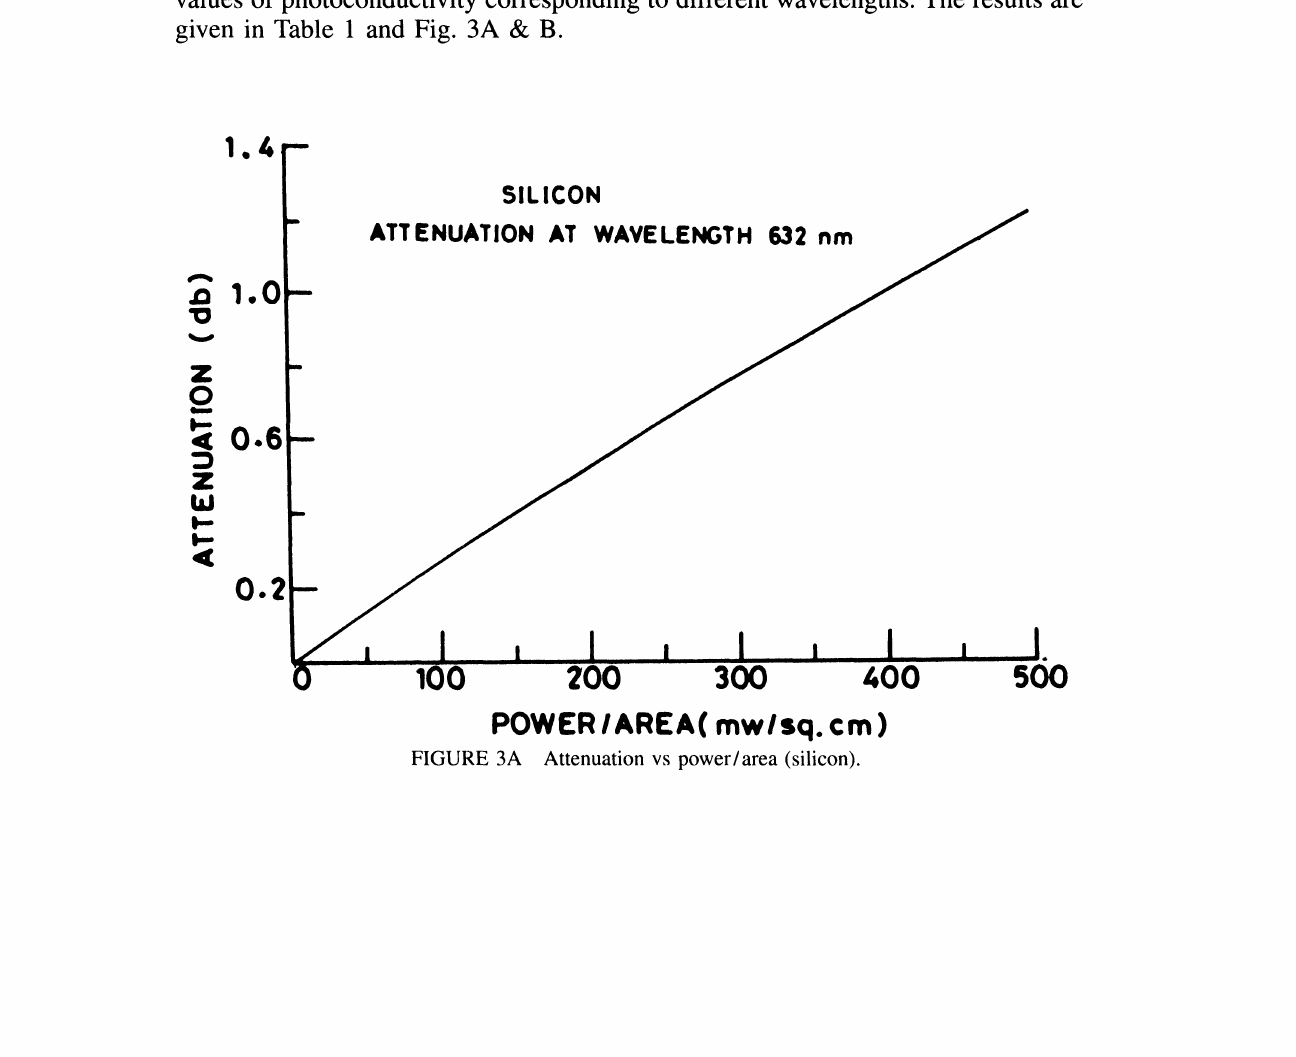
FIGURE 3A Attenuation vs power/area